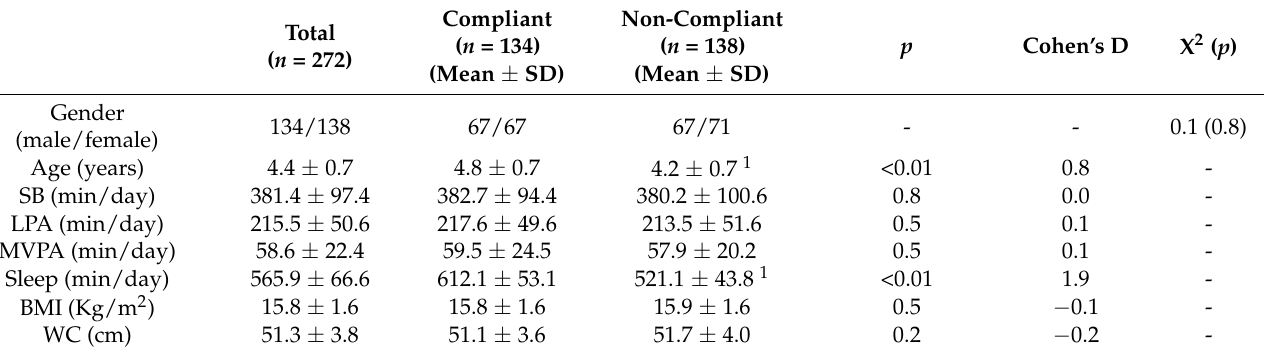
Table 1. Children’s descriptive data.